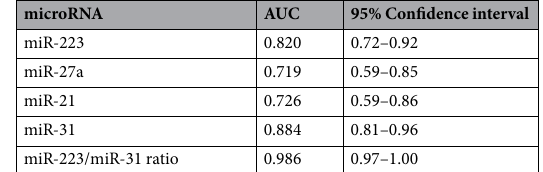
Table 2. Peritoneal microRNAs for the diagnosis of PD-related peritonitis. ROC curve analysis of the potential of individual microRNAs, as well as the ratio of miR-223/miR-31, to discriminate between stable and infected